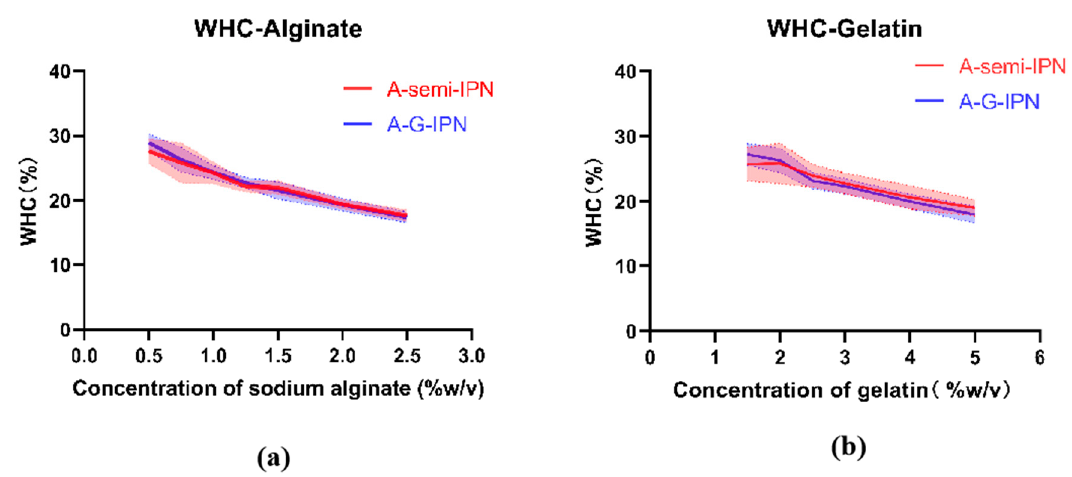
Figure 4. Water holding capacities (WHCs) of the alginate-semi-interpenetrating polymer network (A-semi-IPN) and alginate-gelatin-interpenetrating polymer network (A-G-IPN). ( a ) WHCs of the A-semi-IPN and A-G-IPN hydrogels along with di ff erent alginate concentrations. ( b ) WHCs of the A-semi-IPN and A-G-IPN hydrogels along with di ff erent gelatin concentrations. There are no statistical significance between the A-semi-IPN and A-G-IPN hydrogels in WHCs.